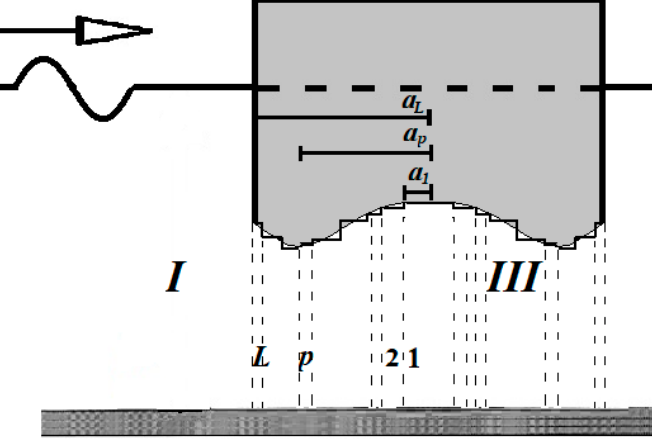
Figure 3. Discretization of the flow field around an axisymmetric arbitrary shape floater.